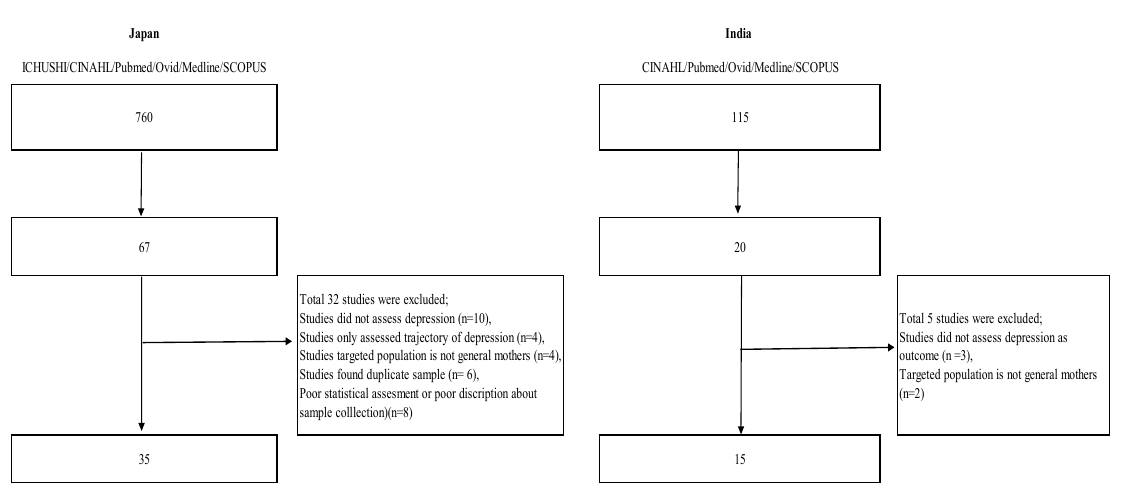
Figure 1. Related factors on perinatal depression systematic review: Flow diagram.